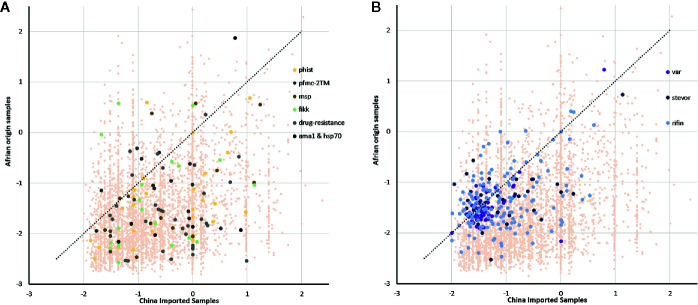
Tajima’s D value of all genes summarizing the difference of balanced selection between China-imported samples (n=9) and native Ghanaian (n=92) reference samples. The lower mean value in local samples suggested a stronger selection pressure from African hosts. (A) Some important genes/gene families showed the same trend as that of the gene background, and these genes/gene families include phist, 2TM, msp1, and drug-resistance genes. (B) Unlike the background, there was not much difference in variant surface antigen (VSA) gene families between the imported and local groups.